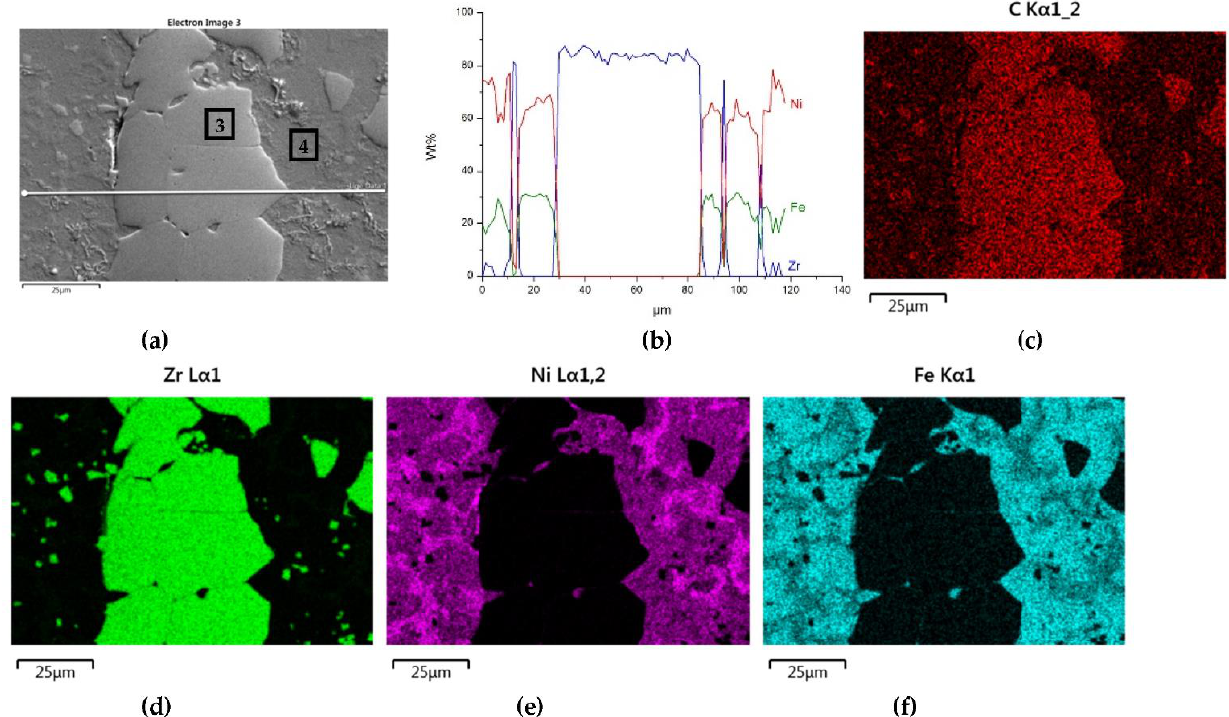
Figure 8. NiBSi-ZrC layer: SEM micrograph with points of the quantitative analysis marked ( a ), linear propagation of components along the marked line ( b ) and EDS maps of C ( c ), Zr ( d ), Ni ( e ), and Fe ( f ) distribution.